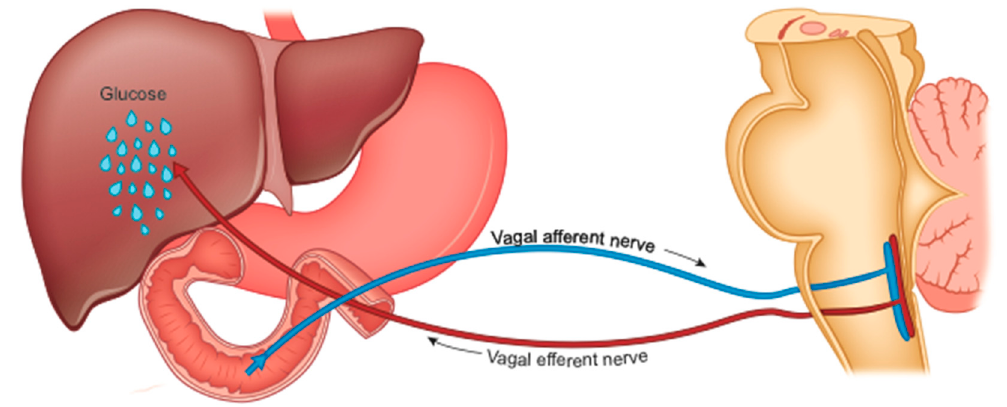
Figure 3. Nervous control of hepatic glucose production by nutrients in the first part of the intestine, through the brainstem vagal nuclei.